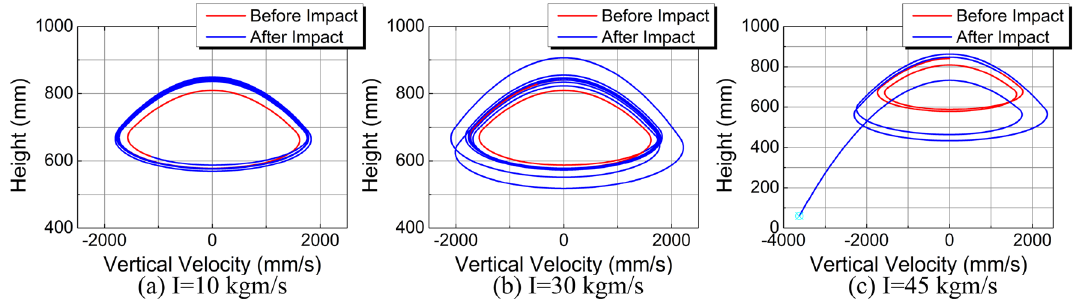
Figure 16. Phase portraits under three different impact forces. ( a ) Phase portraits under the impulse of 10 kgm/s. ( b ) Phase portraits under the impulse of 30 kgm/s. ( c ) Phase portraits under the impulse of 45 kgm/s.